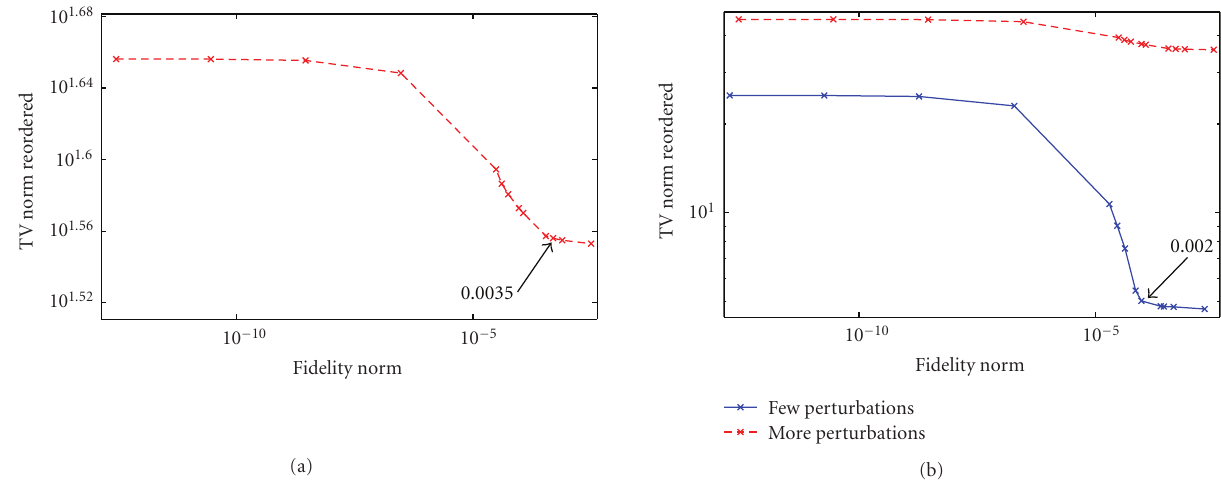
Figure 10: (a) L -curve obtained for reconstruction of the nonsmooth signal in Figure 1(b) from R ∼ 2 Fourier data with reordering, but with large number ( ∼ 65%) of random perturbations in the exact ordering. (b) L -curve obtained for reconstruction of the nonsmooth signal in Figure 1(b) from R ∼ 2 Fourier data with reordering with fewer ( ∼ 21%) random perturbations in the exact ordering. The L -curve in Figure 10(a) is also